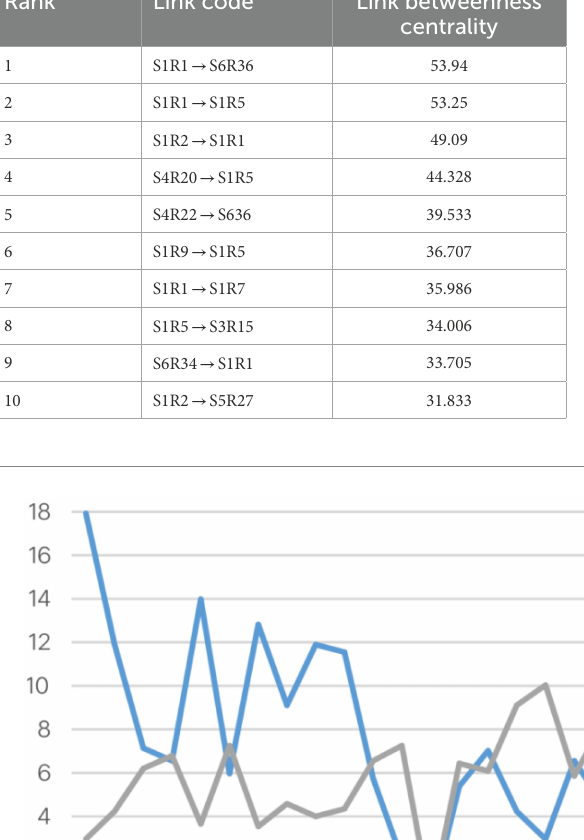
TABLE 4 Top 10 social stability risk factors by link betweenness centrality. Rank Link code Link betweenness